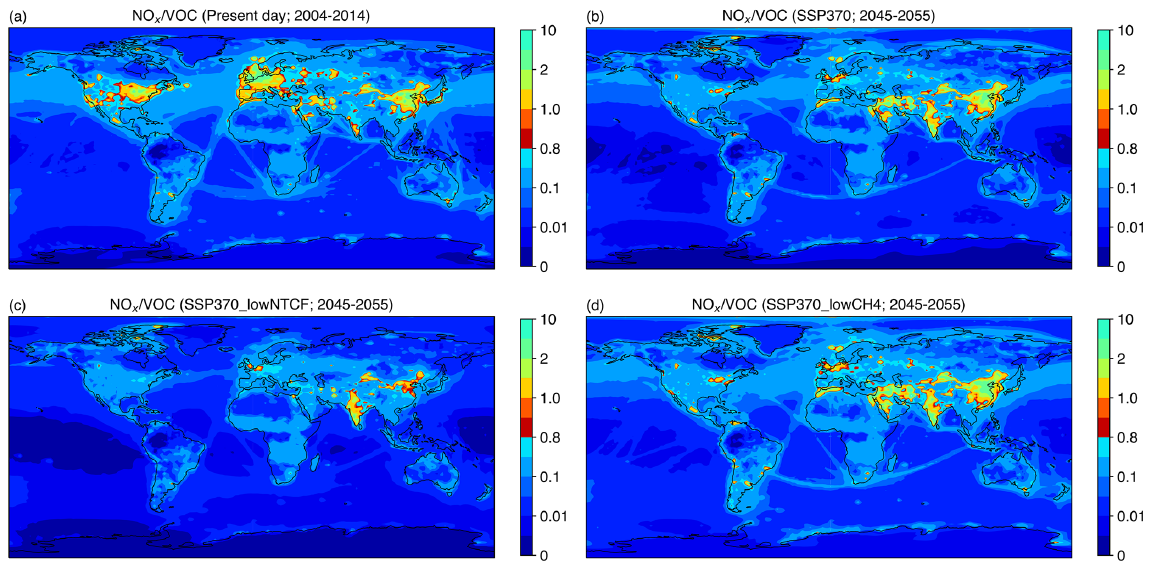
Figure 9. Spatial distributions of annual mean NO x / VOC in the present day (2004–2014; a ) and under SSP3-7.0 (b) , SSP3-7.0-lowNTCF